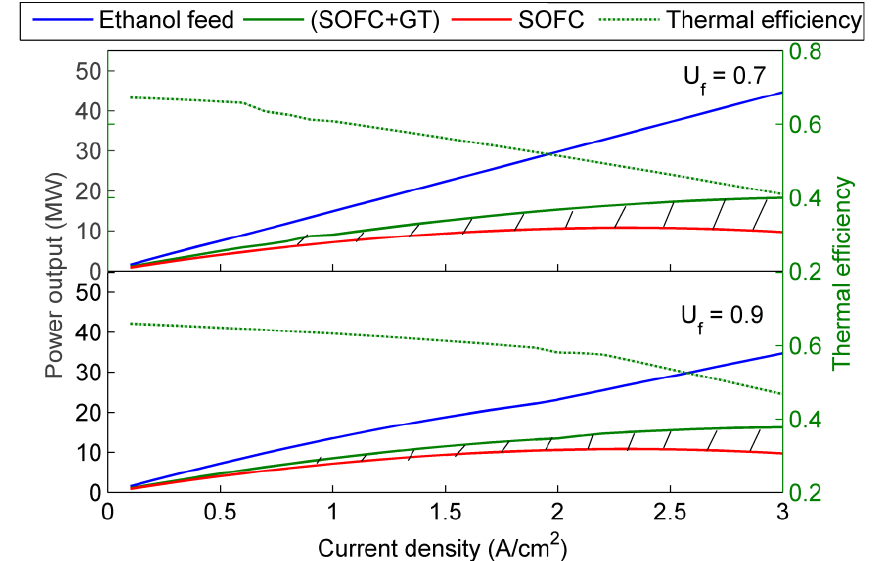
Figure 11. The effect of current density and fuel utilization factor on the power output of the SOFC device, on the total power output of the SOFC-GT, and on the fuel consumption; T = 600 FC